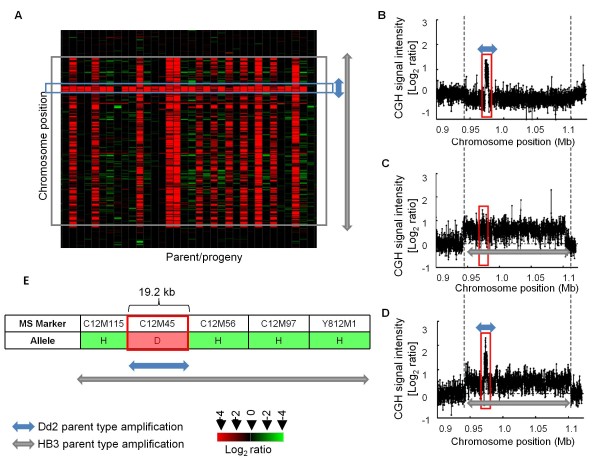
Inheritance of a complex, multiallelic CNV at a segregating CNV locus. The Chr 12 locus harbors two unique CNVs: one specific to the HB3 parent (~161 kb, grey arrow) and the other to the Dd2 parent (~5 kb, blue arrow). 34 genes overlap with the HB3-type CNV and 3 genes with the Dd2-type CNV (which are common to both of the CNV types, demarcated by blue box). A) Heat map illustrates the increased relative probe signal intensities in the Dd2/progeny lines (red) in comparison to the reference HB3 parent. (B - D) Scatter plots represent the relative hybridization intensities as a log2 (test/HB3) for progeny inheriting Dd2-type CNV allele (B, inherited by 23 progeny) HB3-type CNV allele (C, inherited by 11 progeny) and a single progeny, that inherited both parental CNV alleles at this locus (D). (E) Linkage analysis with MS markers confirms a multiallelic region comprising an approximately 19 kb Dd2 allelic region interspersed within a larger HB3 allelic region overlapping the complex CNV in the progeny strain CH3-61.